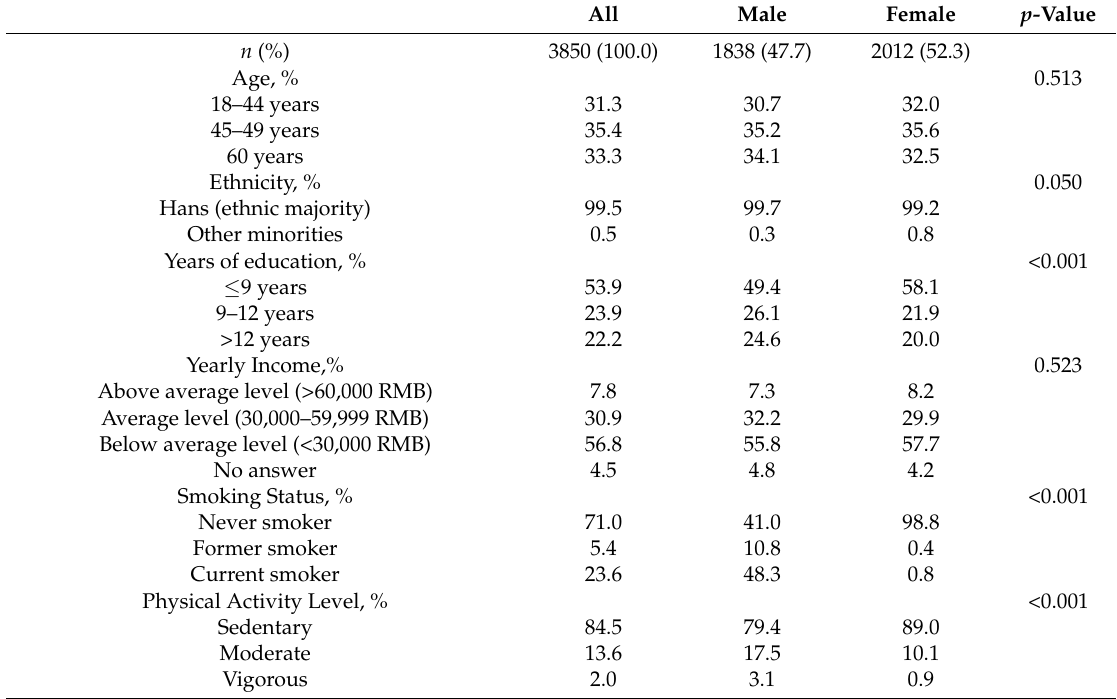
Table 1. Characteristics of participants by sex in SDHS 2012–2013.